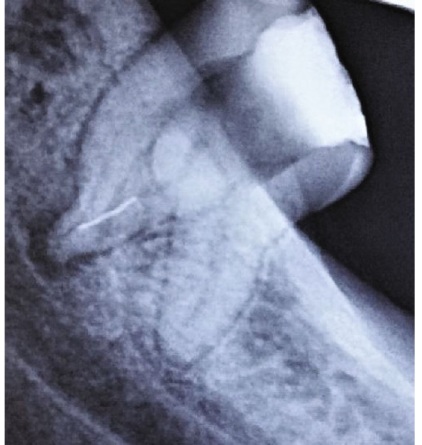
Figure 1: Preoperative radiograph.